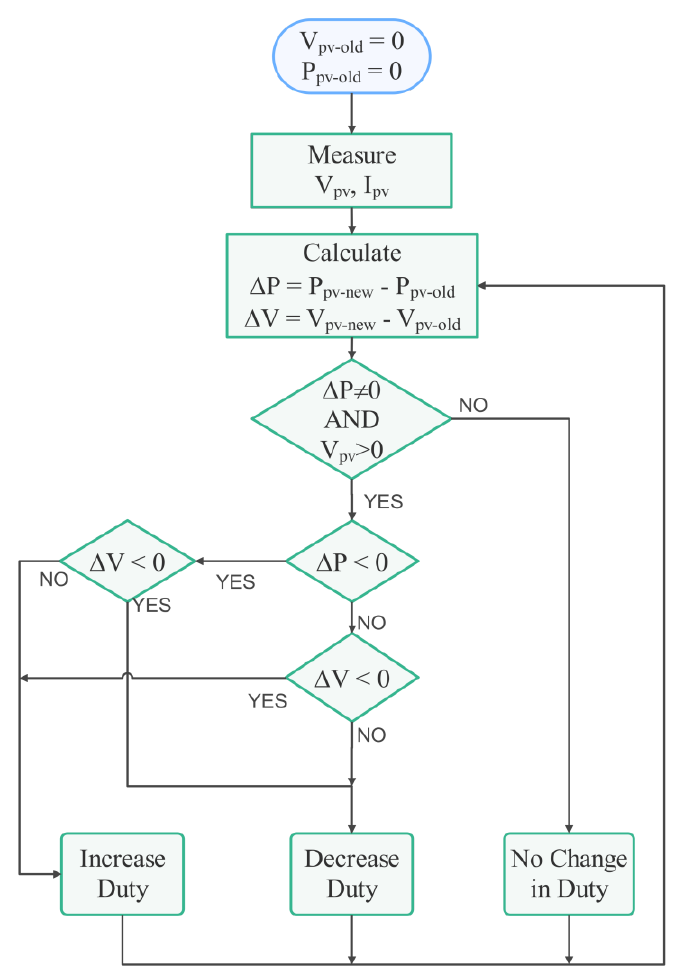
Figure 9 . The P&O MPPT algorithm. Figure 9. The P&O MPPT